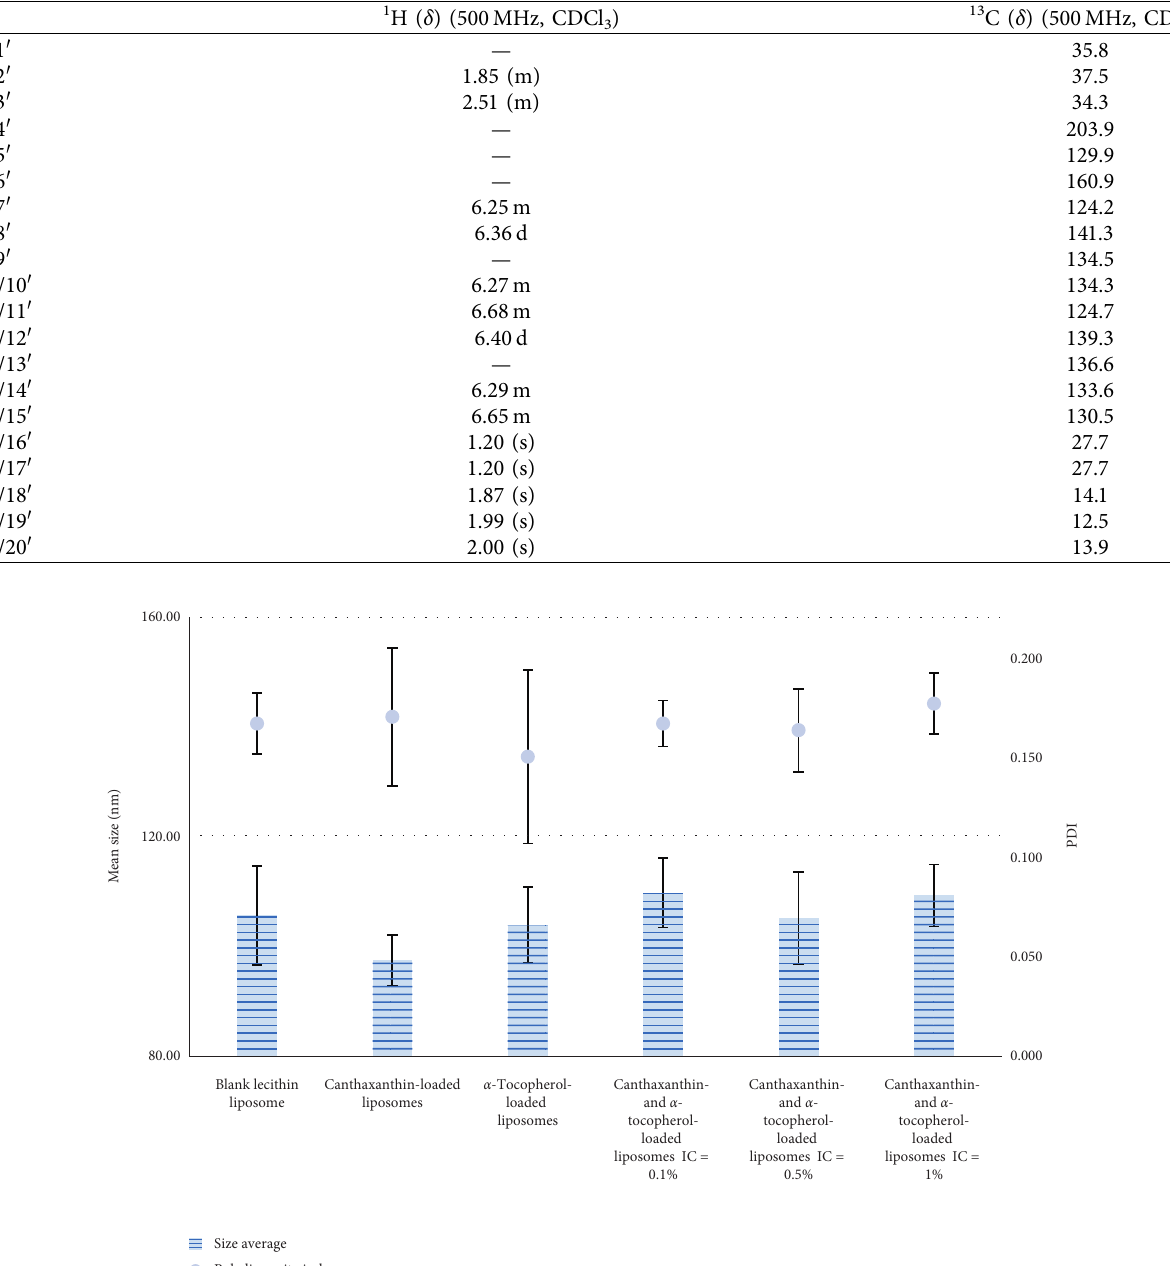
Figure 2: DSM SalmoFan Lineal colorimeter. Table 2: NMR data for canthaxanthin in CDCl